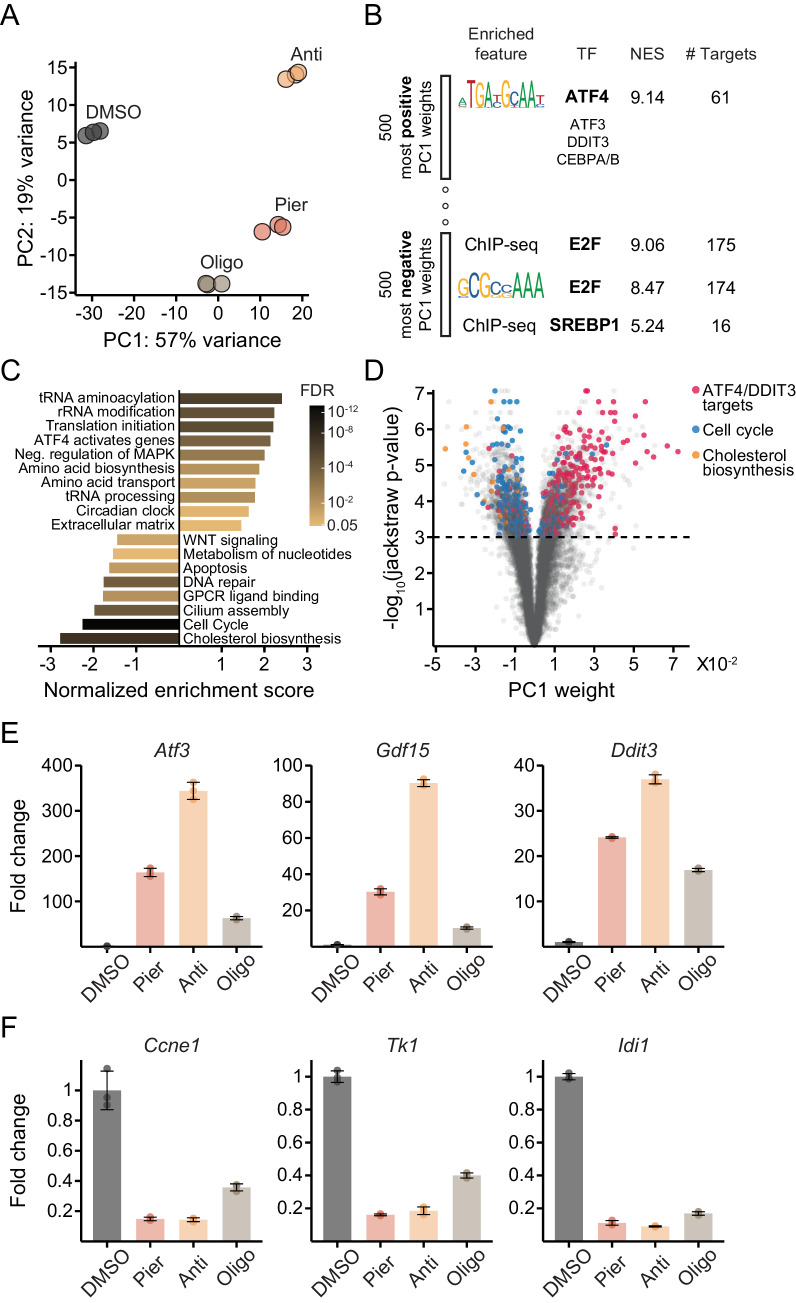
Mechanistically distinct mitochondrial inhibitors trigger the ISR and depress proliferative gene expression in myoblasts.(A) PCA of gene expression levels derived from RNA-seq in myoblasts treated with inhibitors for 10 hr. N = 3 (same samples as in Figure 1D). Pier, piericidin; Anti, antimycin; Oligo, oligomycin. Detailed results are provided in Supplementary file 1. (B) Enriched features in the promoters of the 500 genes with the most positive PC1 weights and the 500 genes with the most negative weights, based on iRegulon analysis of transcription factor binding motifs and ChIP-seq peaks. TF, transcription factor; NES, normalized enrichment score; # Targets, number of gene targets. Detailed results are provided in Supplementary file 2. (C) Gene set enrichment analysis of REACTOME pathways using PC1 weights as the gene ranks. Detailed results are provided in Figure 2—source data 1. (D) Volcano plot relating each gene’s PC1 weight (x-axis) and jackstraw P-value for significance of association with PC1 (y-axis). (E) Fold-change from DMSO derived from RNA-seq for representative ATF4/DDIT3 target genes strongly upregulated along PC1 (Atf3, activating transcription factor 3; Gdf15, growth/differentiation factor 15; Ddit3, DNA damage-inducible transcript 3). Mean ± SD. (F) Fold-change from DMSO derived from RNA-seq for representative cell cycle pathway genes (Ccne1, G1/S-specific cyclin-E1; Tk1, thymidine kinase, cytosolic) and a cholesterol pathway gene (Idi1, isopentenyl-diphosphate delta isomerase 1) strongly downregulated along PC1. Mean ± SD.Figure 2—source data 1.Gene set enrichment analysis.